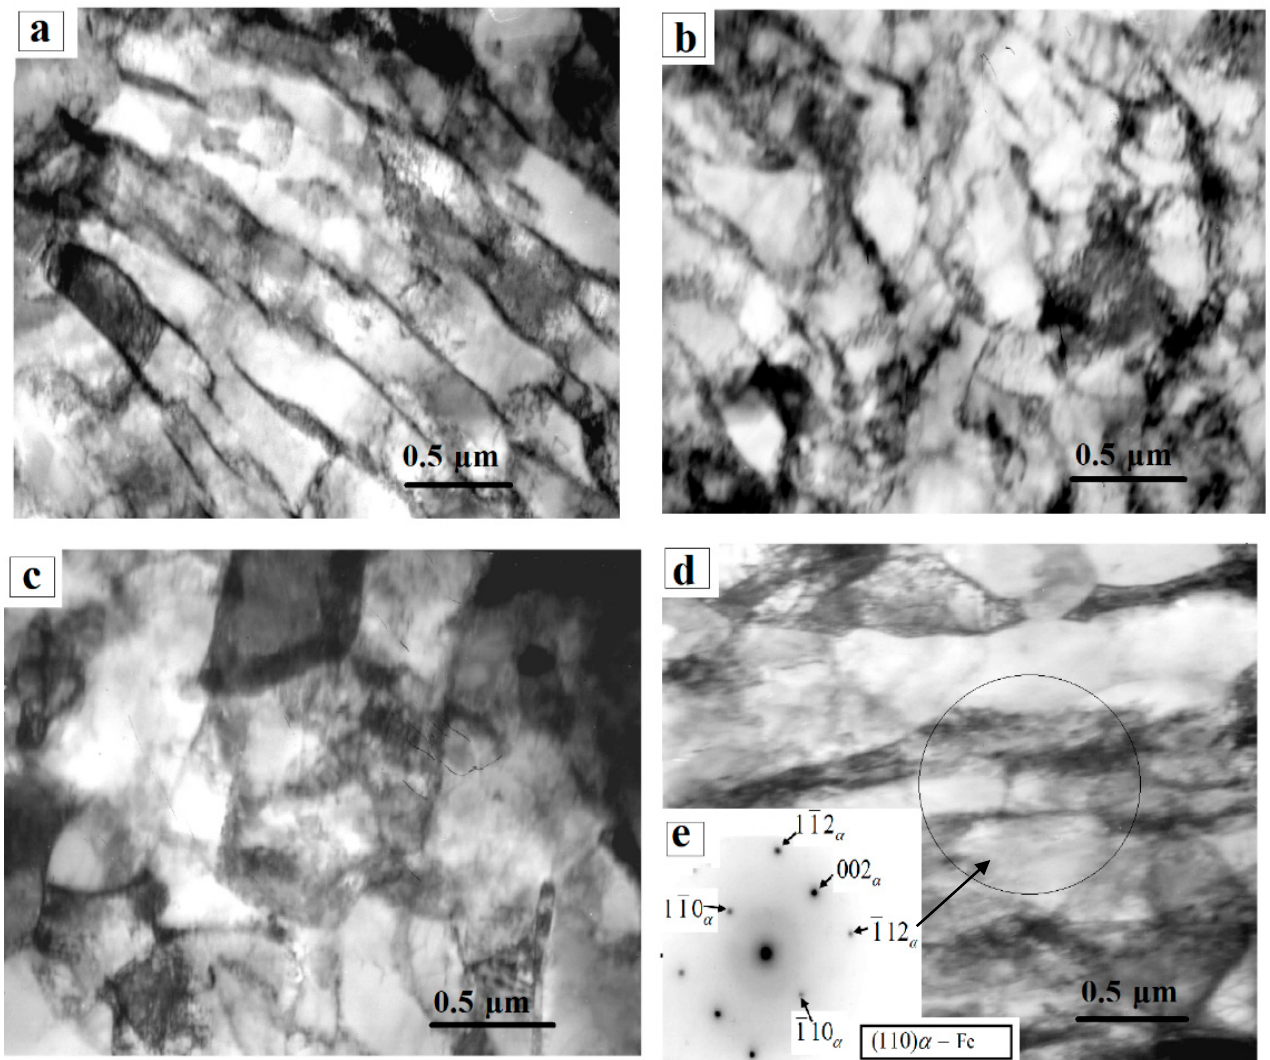
Figure 3. Electron microscopic image of the dislocation structure of 0.34Cr-1Ni-Mo-Fe steel in the initial state. ( a ) lamellar pearlite, ( b ) primary fragmented perlite, ( c ) ferrite-carbide mixture, ( d ) fragmented ferrite, ( e ) microdiffraction pattern .